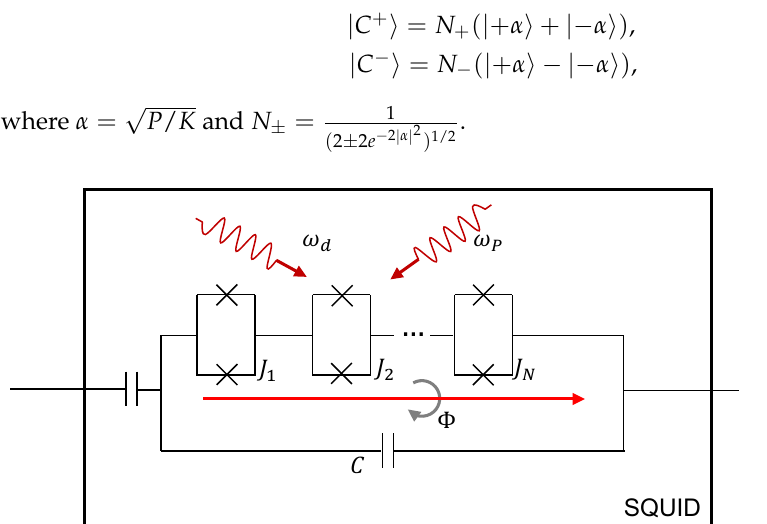
Figure 2. Circuit diagram of the KNPO. The red and gray arrows denote the external flux and the magnetic field, respectively, while two red wave arrows represent the modulated